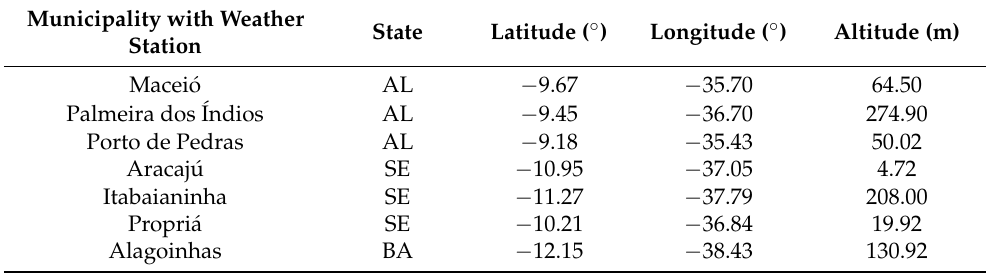
Table 1. Metadata of the conventional weather stations located in the SEALBA region. Source: INMET. Municipality with